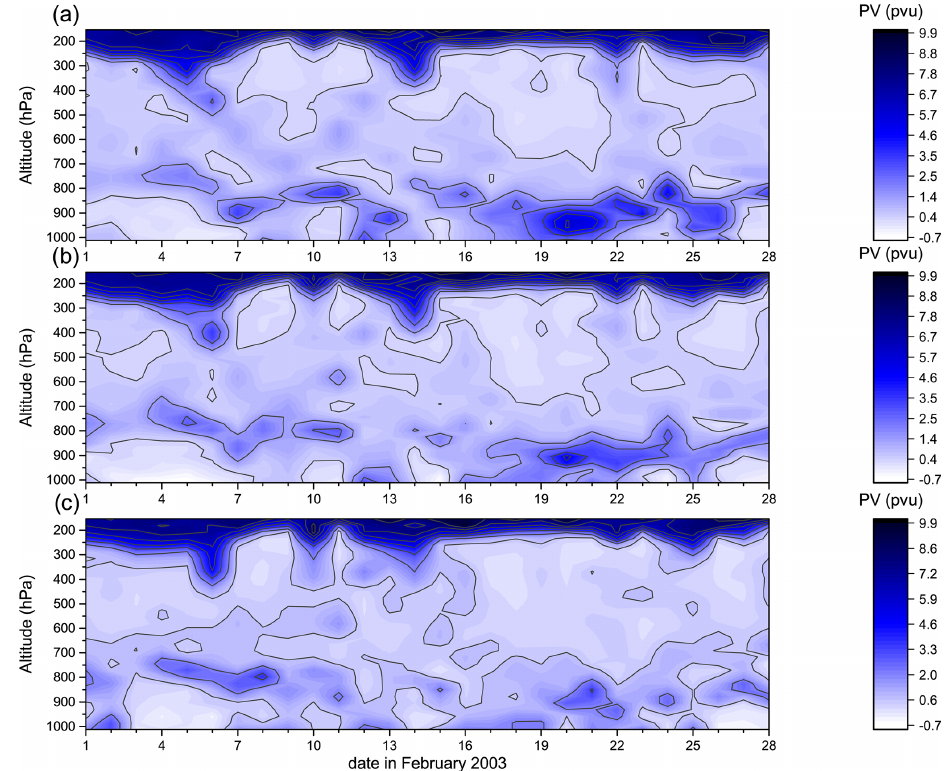
Figure 10. Time–height cross sections of calculated daily potential vorticity during the month of February 2003 at three latitudes: (a) 63 ◦ N, (b) 64.5 ◦ N and (c) 66 ◦ N along the 21 ◦ E